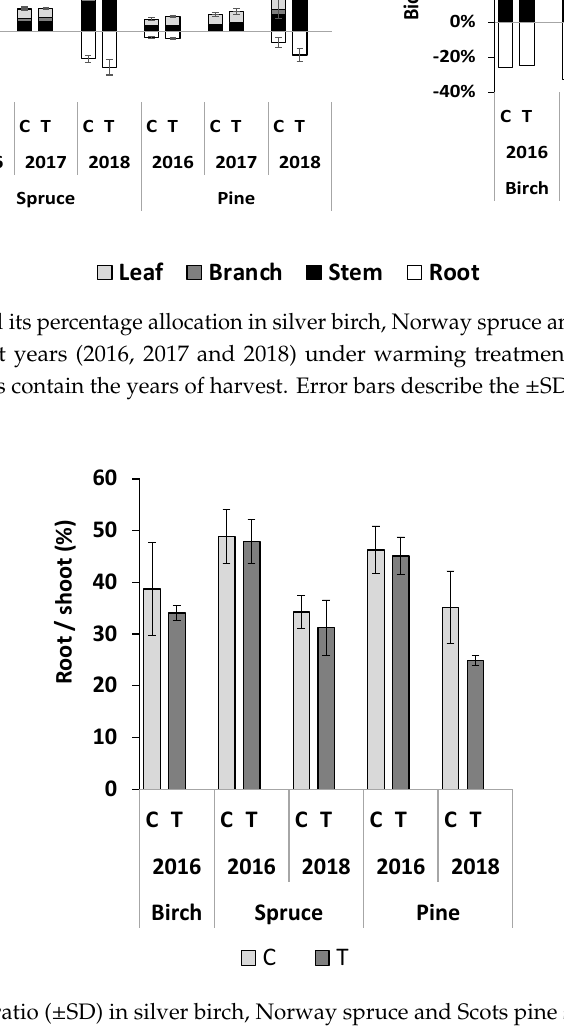
Figure 4. Root:shoot ratio ( ± SD) in silver birch, Norway spruce and Scots pine seedlings harvested in 2016 and 2018 under warming treatment (T) and ambient (C) conditions. Shoot = above ground mass. The x -axes contain the year of plant harvest.